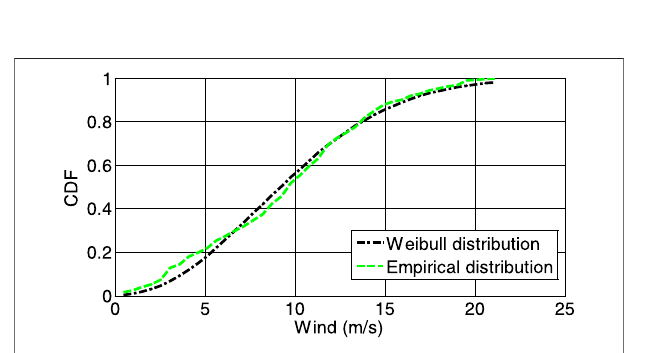
FIGURE 8 | CDF of wind speed.